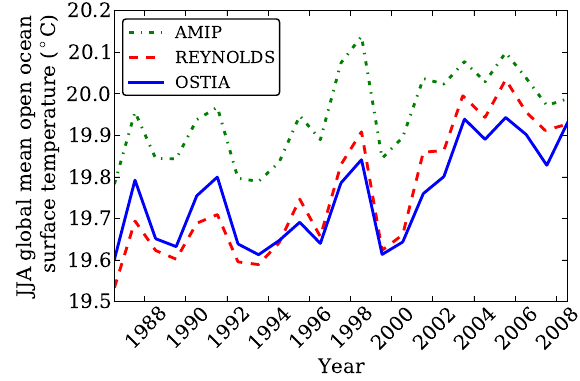
Figure 2. Time-series of global ocean mean JJA surface temperatures for the AMIP-II (dot-dashed green line), Reynolds (dashed red line) and OSTIA (solid blue line) datasets.